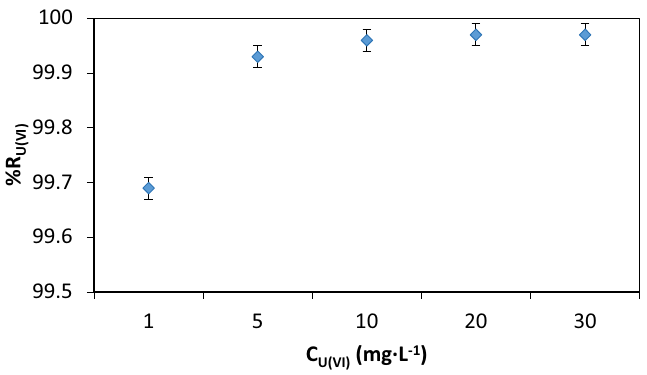
Figure 9. %R = f(U(VI)), V sample = 200 mL, stirring rate 250 RPM, contact time 30 min, pH = 8.75, molar ratio [U(VI)] : [Fe (III)] : [NaOL] = 1 : 75 : 1 × 10 –2 , p = 4 × 10 5 N·m −2 , dilution ratio V sample : V water = 3 :